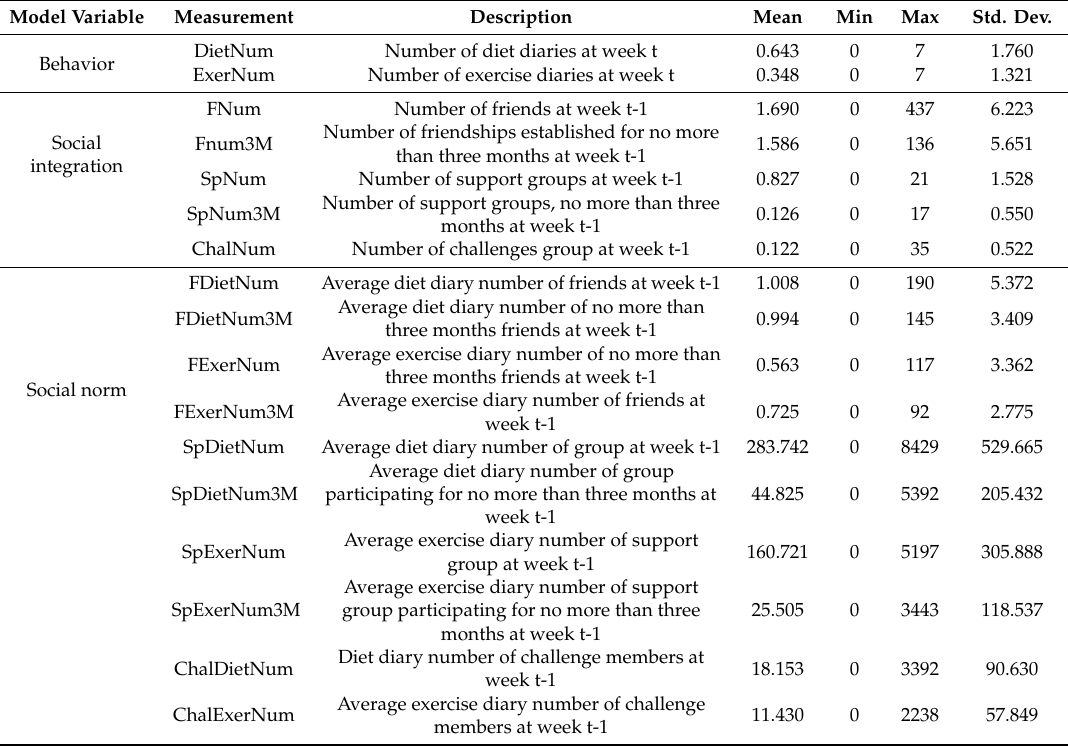
Table 2. Variables description and data